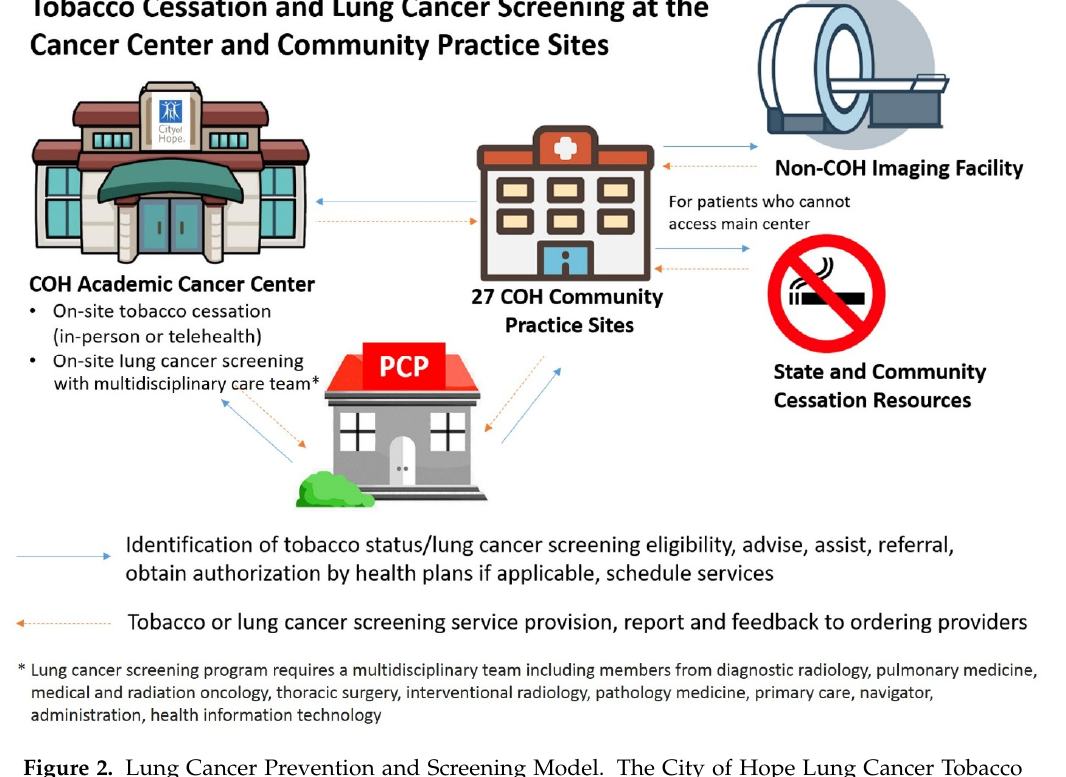
Figure 2. Lung Cancer Prevention and Screening Model. The City of Hope Lung Cancer Tobacco